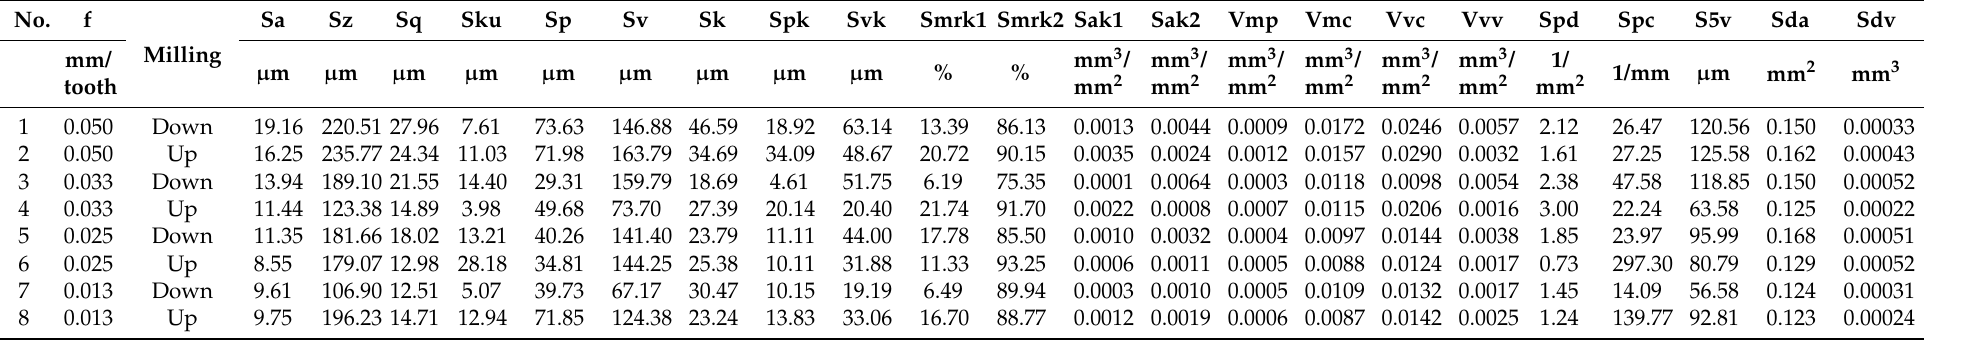
Table 3. Summary of measurement results for 3D